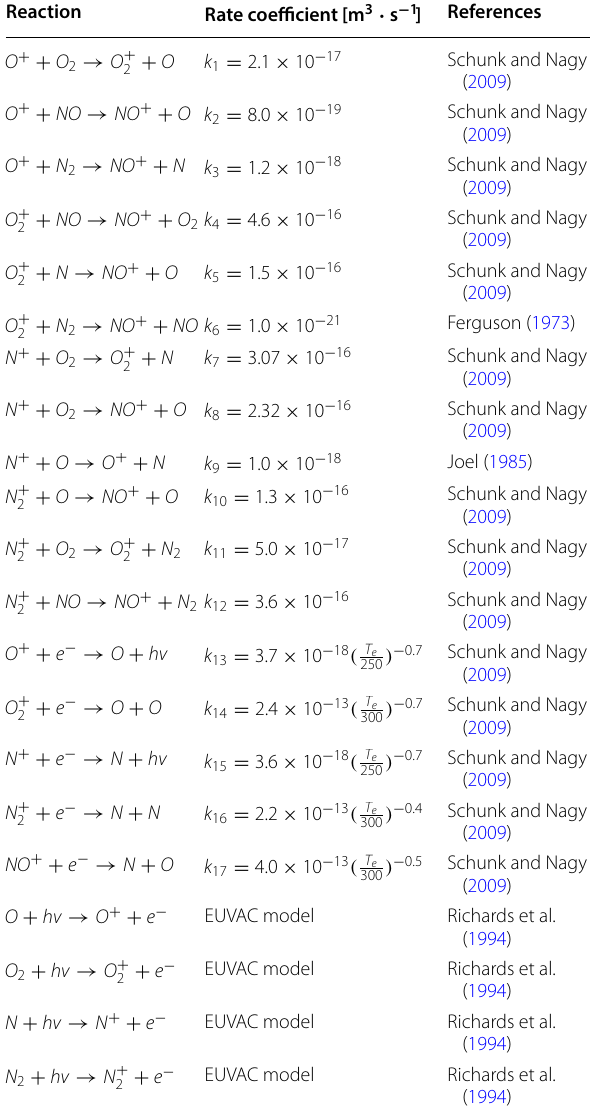
Table 1 Chemical and photochemical reactions of NO + , O